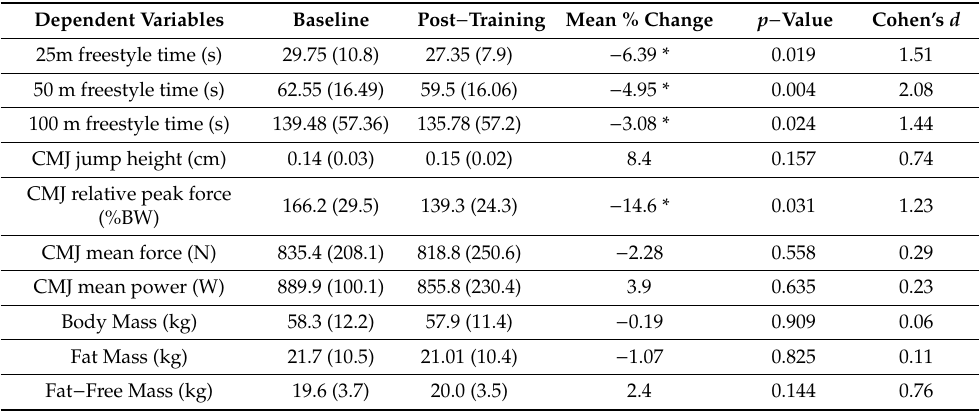
Table 3. Mean (SD) values for swimming performance, jump performance and body composition pre- and post-training, and the mean relative change (%) following the 18-week swimming